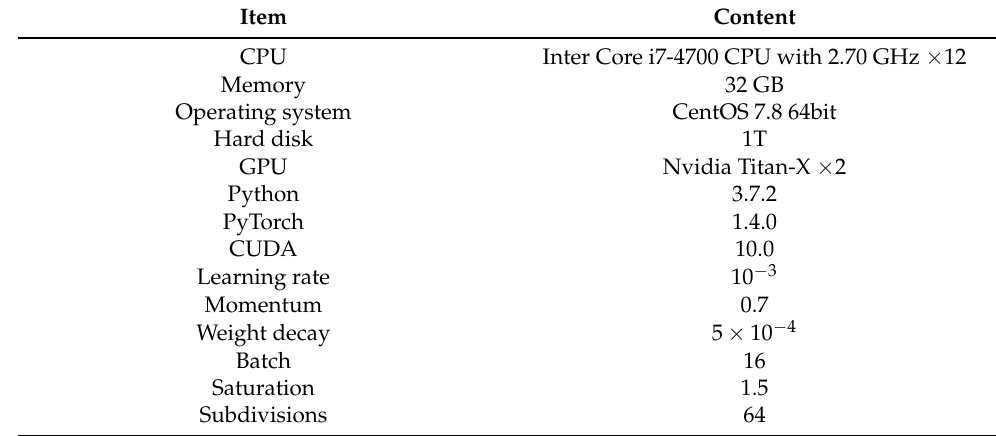
Table 2. Setting of experimental environment and other parameters. Item Content